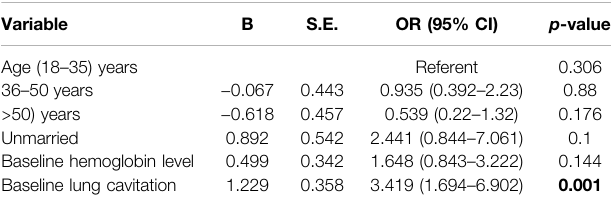
TABLE 7 | Multivariate analysis of risk factors for occurrence of adverse drug reactions.